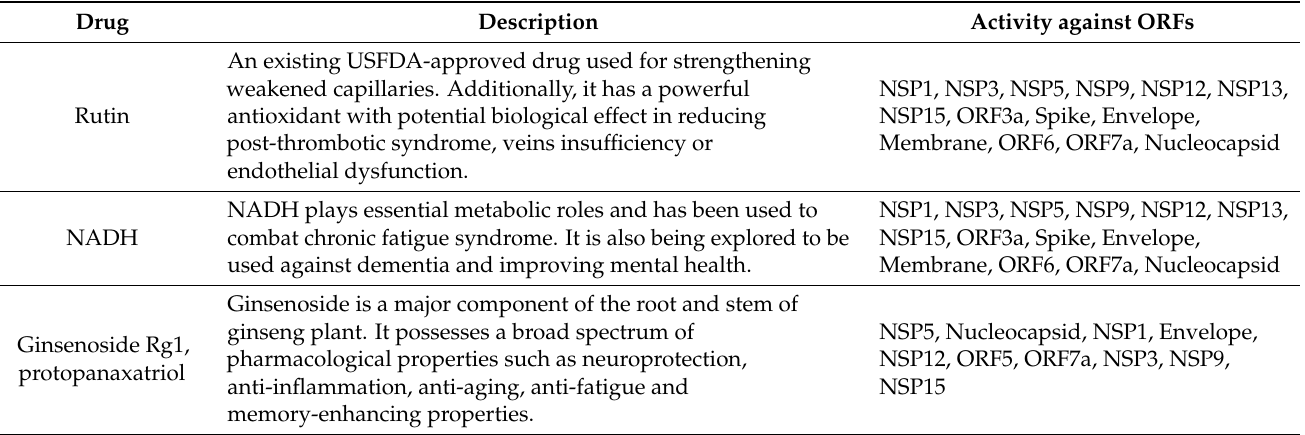
Table 1. Activity of drugs against SARS-CoV-2 proteins.